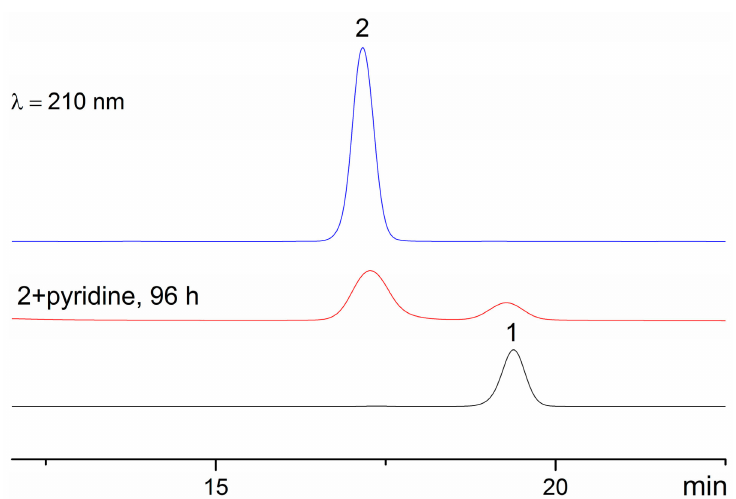
Figure 4. HPLC chromatograms of the epimerized product of 2 in pyridine (retention time, 96 h), and the standards of 1 and 2